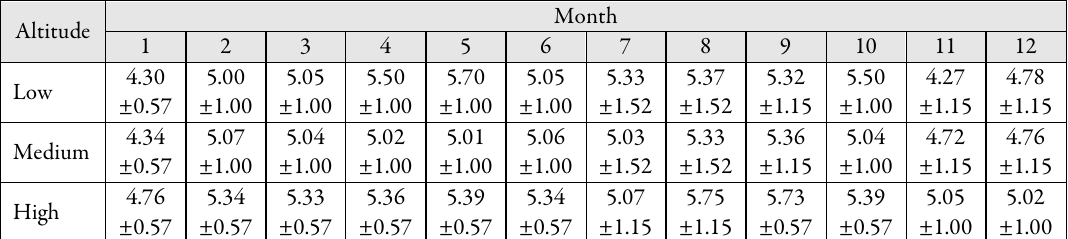
(% of alkaloids) n= 3 P< 0.05. Table 3.Table 3.Table 3.Table 3. Monthly variation with altitude at morning